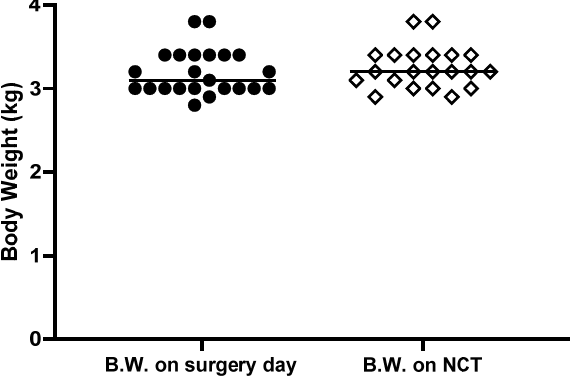
Figure 2. Body weight of the rabbits between the perineurial administration and the nerve conduction study (NCS). Rabbits were weighed before the perineurial administration of the formulations and allowed to recover for 2 weeks before being weighed again and subjected to the NCS.